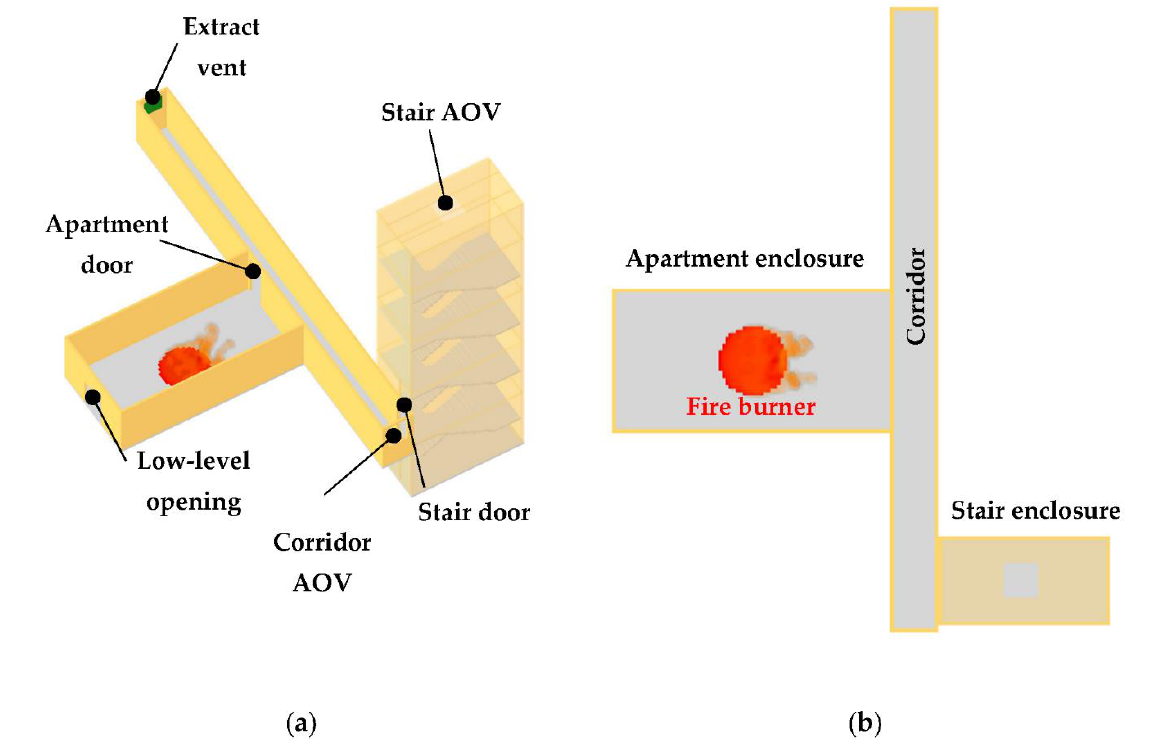
Figure 1. Exemplar geometry visualisation presented in the Smokeview software package [18]: ( a ) 3D perspective view; and ( b ) plan view.